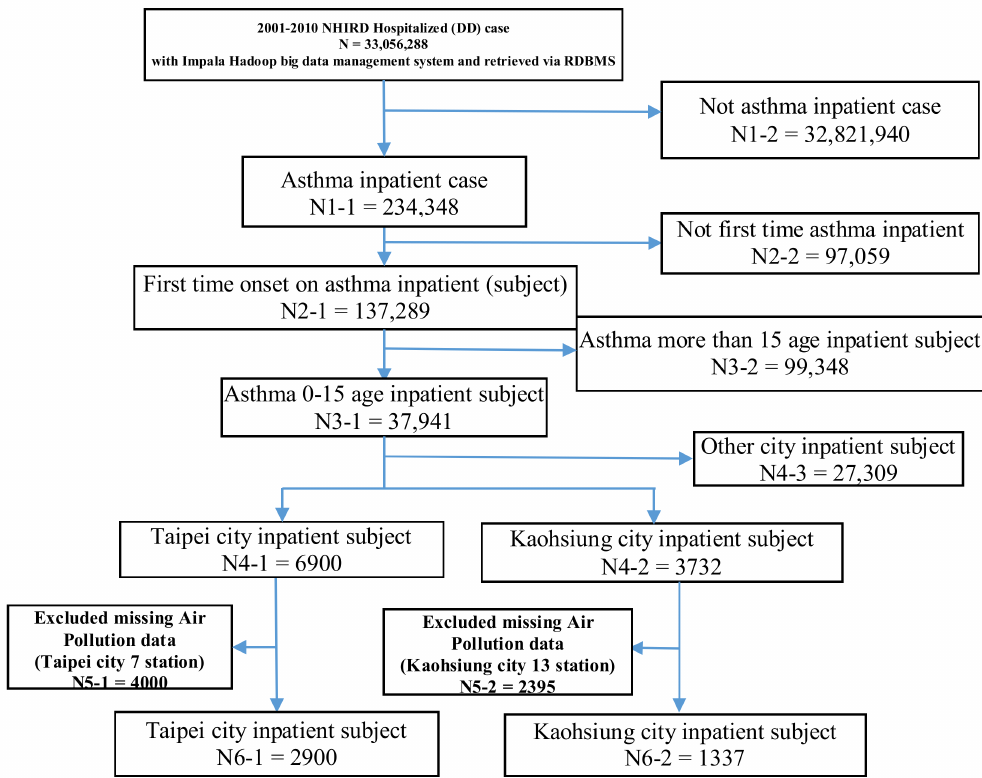
Figure 1. The study